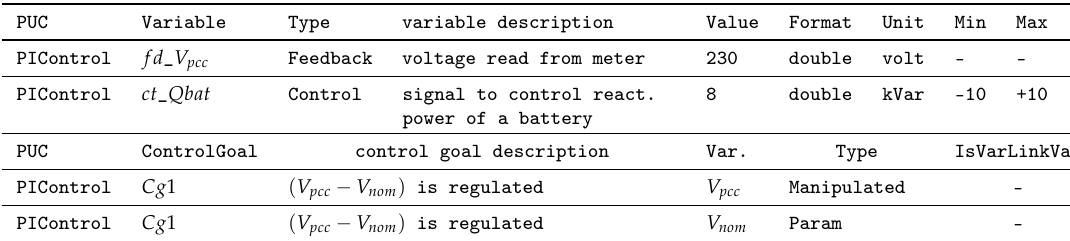
Table 7. Tabular data to implement detail of a PUC (e.g.,